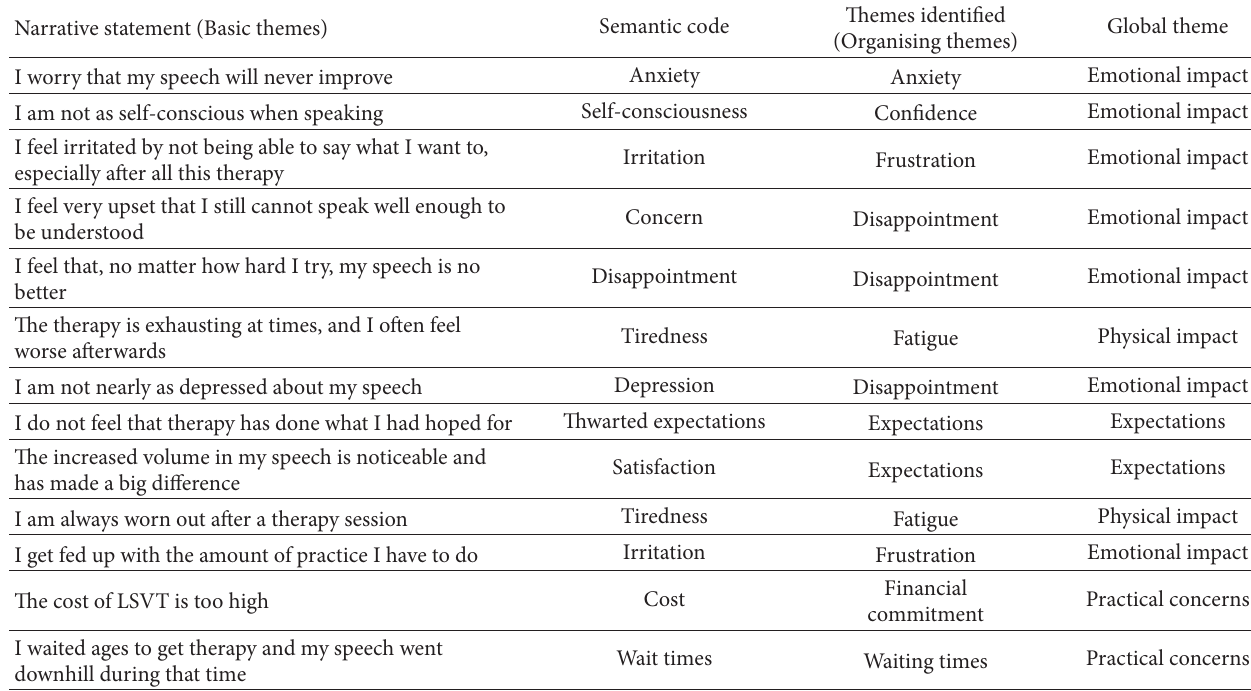
Table 2: A simplified illustration of the preliminary development stages of the thematic